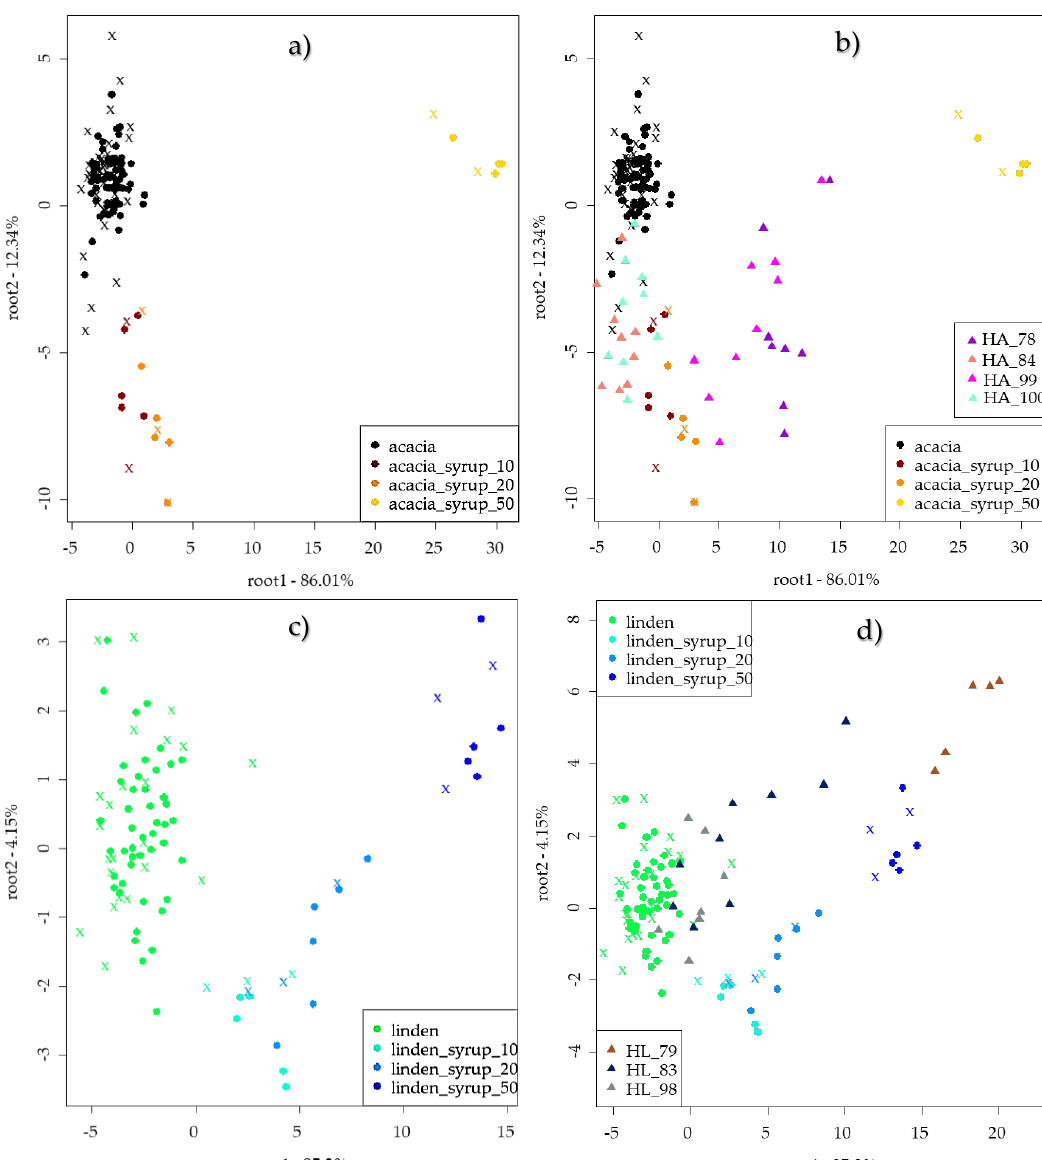
Figure 3. Results of the electronic nose LDA model for classification of authentic and adulterated acacia ( a ) (n= 127) and linden ( c ) (n= 94) honeys and models for independent prediction with EUnonEU blends for acacia ( b ) (n=127+35) and linden ( d ) (n= 94+21) honeys;  training,  validation and  independent prediction.